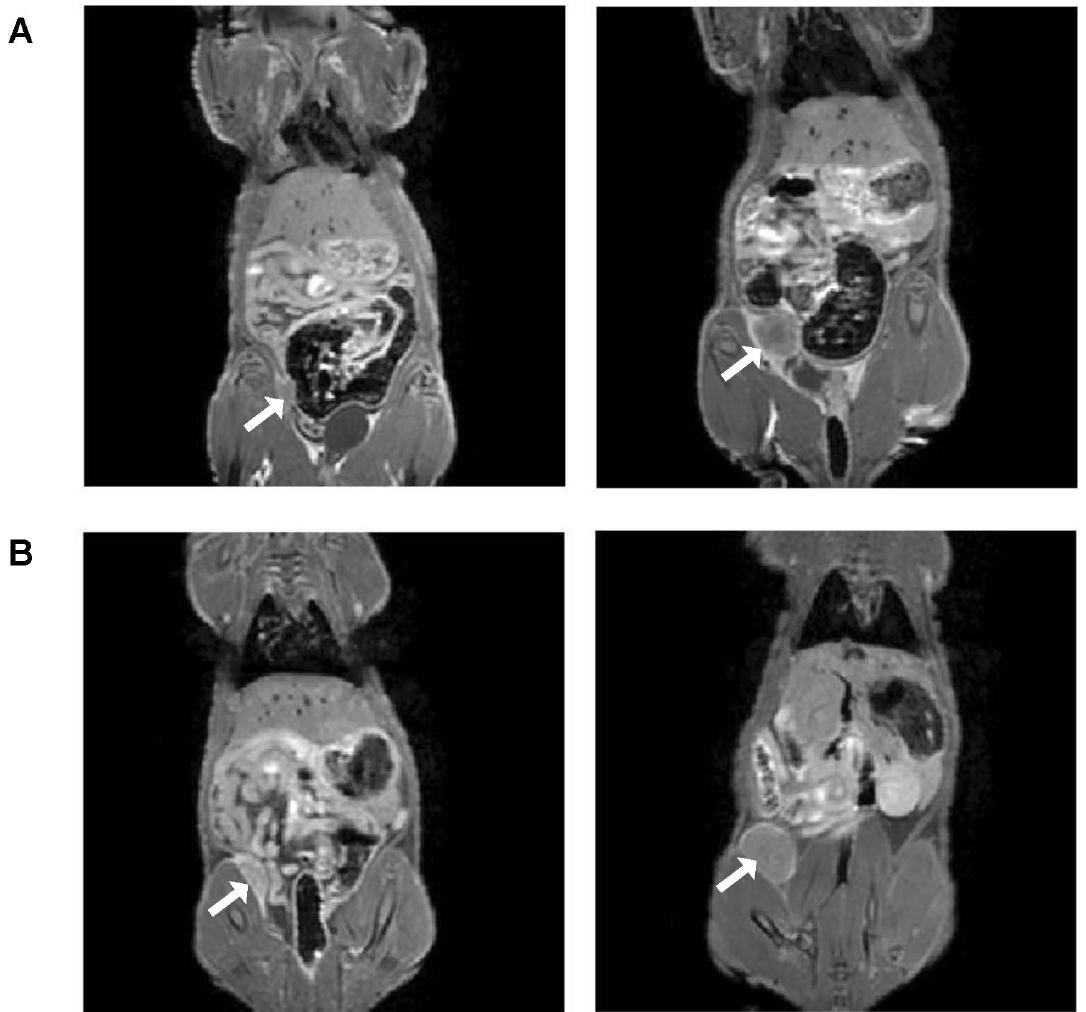
Figure 3. In-vivo gadolinium contrast-enhanced magnetic resonance imaging (MRI) of orthotopic breast tumors in nude rats at 3 Tesla. T 1 -weighted spin-echo images acquired post-contrast injection at early and late stages of tumor development are shown in two rats. (A) MRI was acquired 6 days (left) and 20 days (right) after cell inoculation in the mammary fat pad. (B) MRI was acquired 6 days (left) and 13 days (right) after cell inoculation in the mammary fat pad. Arrow points to tumor. doi:10.1371/journal.pone.0097950.g003 PLOS ONE |